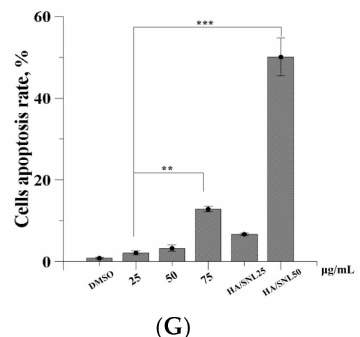
Figure 8. Annexin V-FITC/PI-based apoptosis profiles of A549 cells after a 24-h SNL and HA/SNL